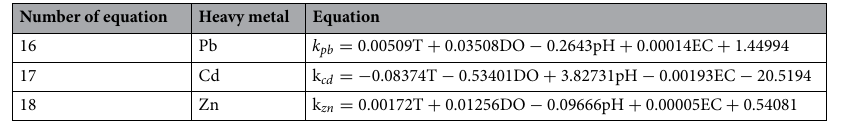
Table 5. Linear equations of reaction coefficient of dissolved phase of heavy